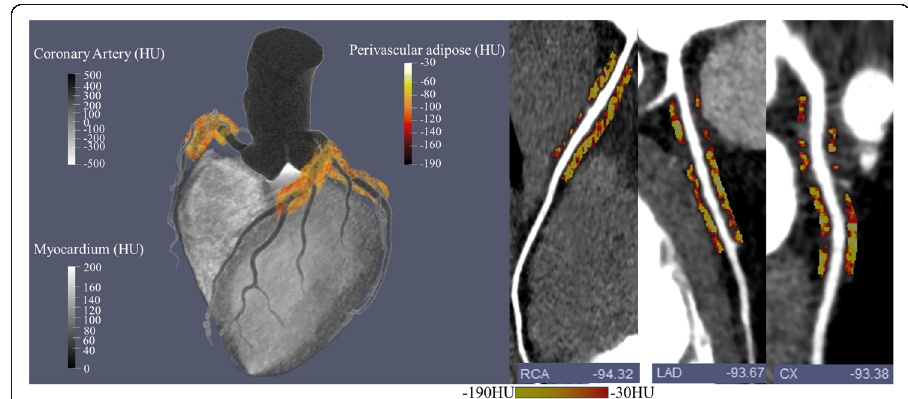
Fig. 5 Schematic diagram of pericoronary adipose tissue and FAI. (left) 3D volume rendering image of pericoronary adipose tissue (orange color); (right) the numbers in the lower right corner represent the values of fat attenuation index. RCA = right coronary artery; LAD = left anterior descending artery; CX = circumflex artery; HU = Hounsfield